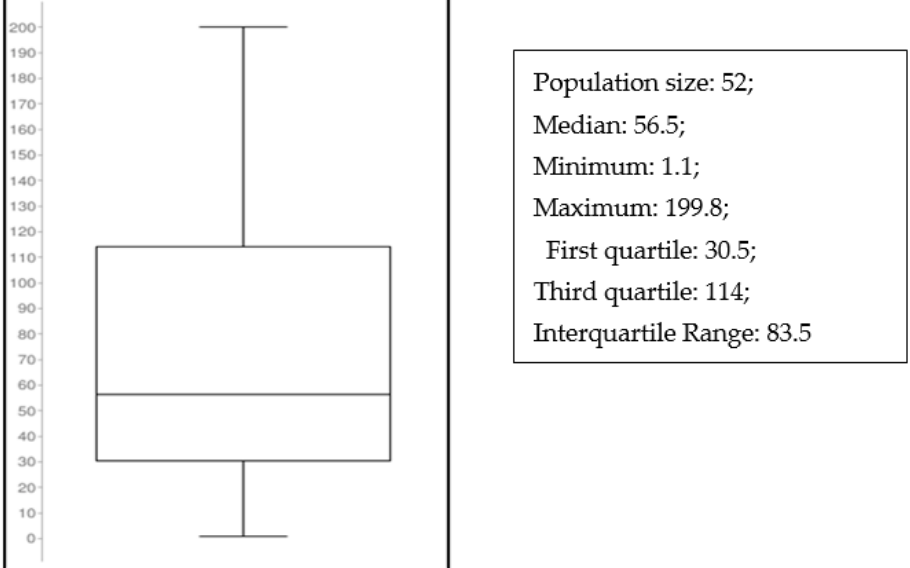
Figure 4. Box plot showing the spread of the C concentration measured in 52 real patients treated because of carbapenem-resistant Gram-negative infections.